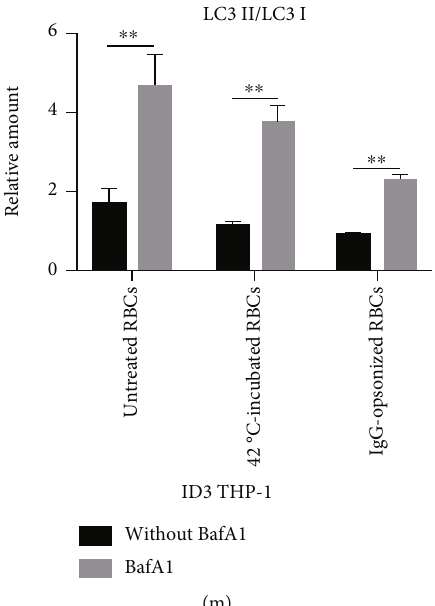
Figure 3: Autophagy markers determined via immunoblotting. (a) Expression of two autophagy markers, namely, p62 and LC3, in THP-1 cells after their engulfment of RBCs is determined with immunoblotting. The rapamycin group is the autophagy positive control. BafA1 is used as the autophagy inhibitor. (b) – (d) Histograms illustrating the relative amounts of p62 and LC3 II to GAPDH and those between LC3 II and LC3 I. (e) – (m) Relative amounts of p62 and LC3 II of THP-1 cells coincubated with three di ff erent RBCs with or without bafromycin. ∗ p < 0 : 05 , ∗∗ p < 0 : 01 , and ns: not signi fi